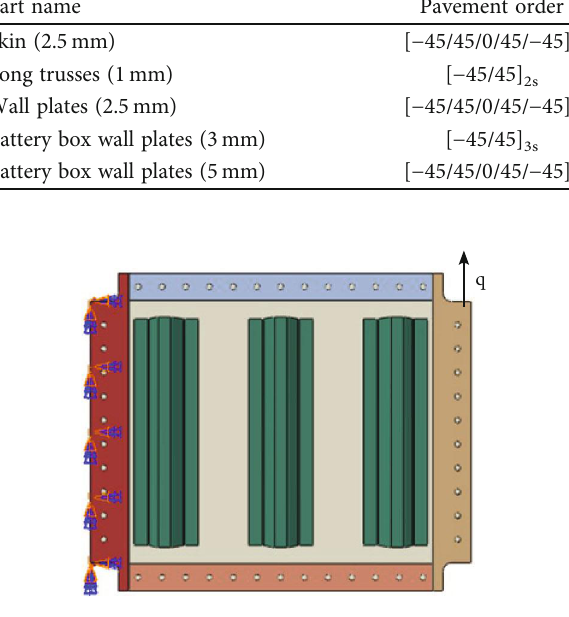
Figure 5: Short side sheared.